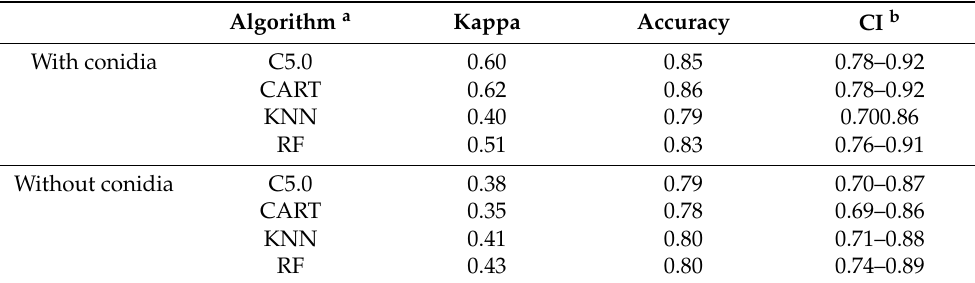
Table 2. Metrics of different machine learning algorithms for predicting the conidia level per day with data sets that either included conidia or not. Algorithm a